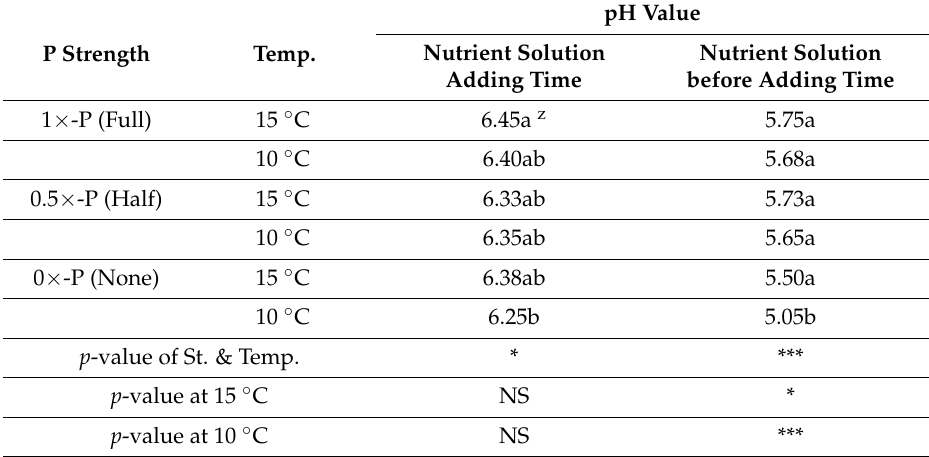
Table 2. The pH values of the nutrient solution at the adding time and before the adding time.